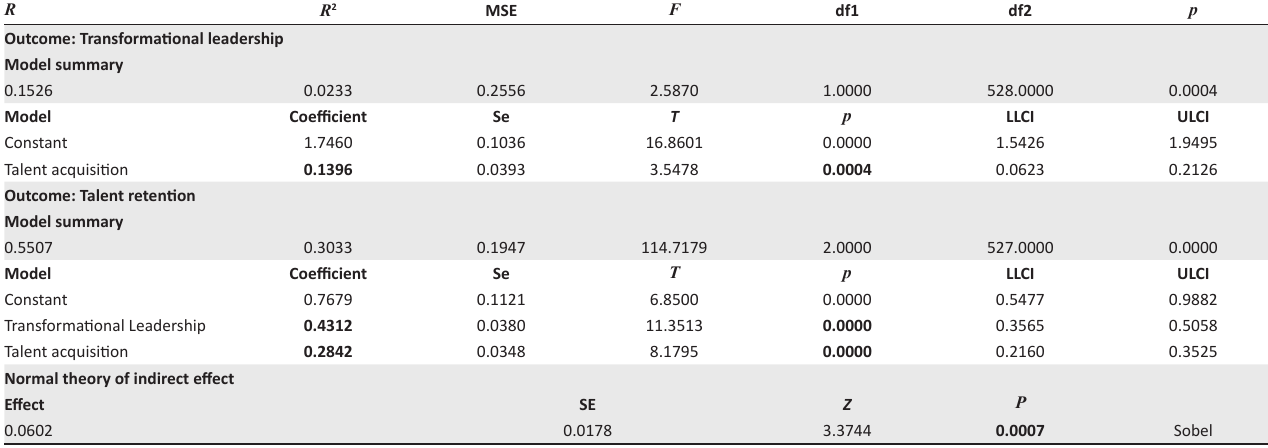
TABLE 10: Leadership mediation model.